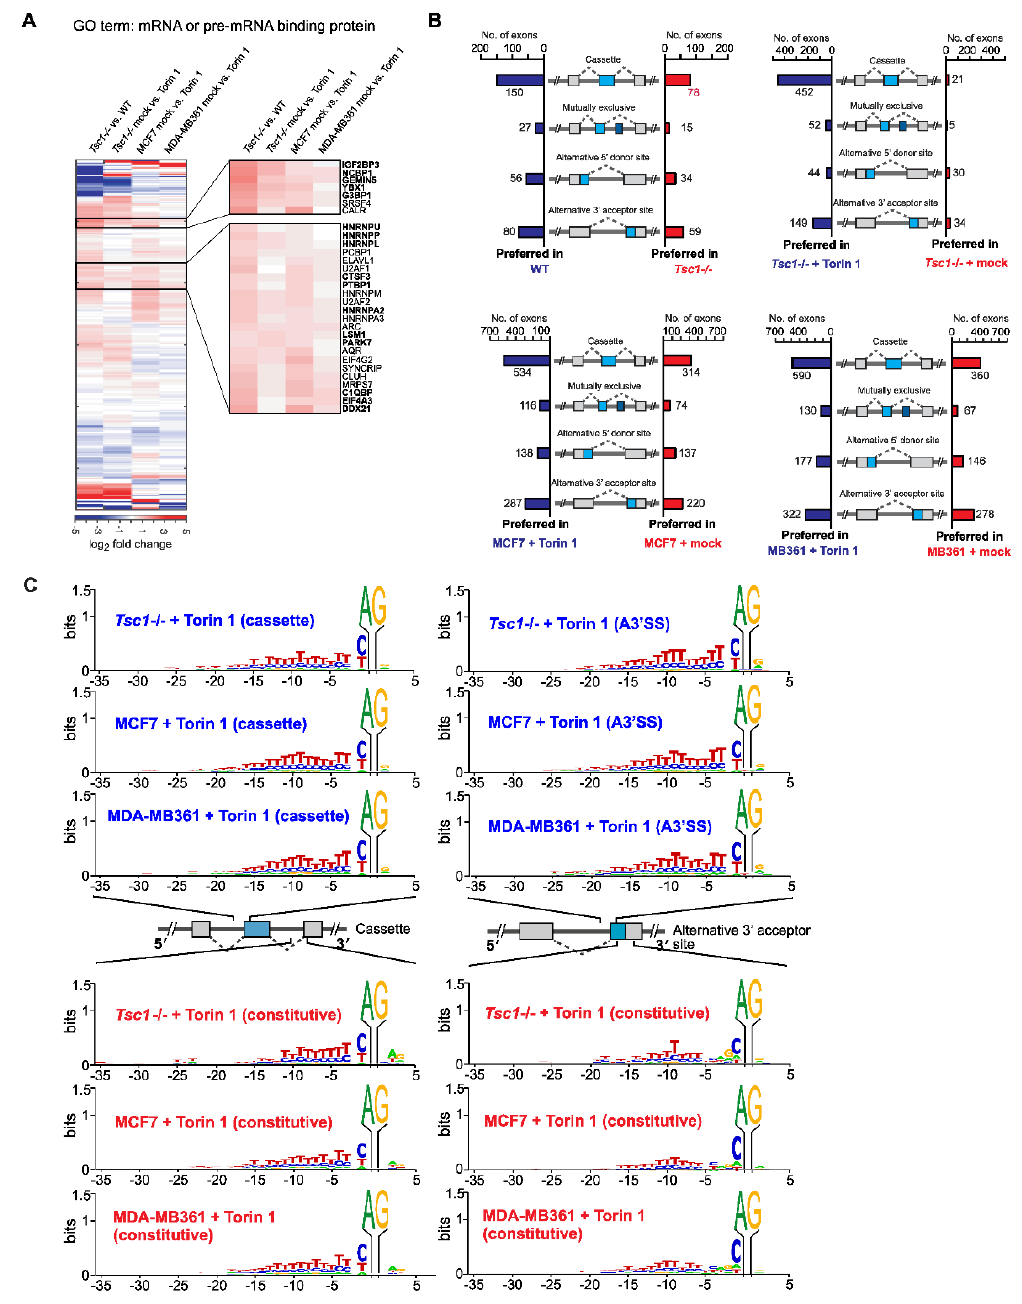
Figure 1. The mTOR-activated transcriptome features widespread exon skipping. ( A ) Hierarchical clustering of select RNA-binding proteins (RBPs) using differential gene expression analysis in low and high mTOR cellular environments. Comparisons were made in the combination of cells as indicated. The x-axis indicates the 285 different RBPs analyzed. The y-axis shows the combination of comparisons. The expression level is color-coded as shown in the scale bar and represents the log2 fold changes of gene expression. ( B ) Analyses of four different types of alternative splicing events in WT vs. Tsc1-/- MEFs; Tsc1-/- MEFs mock vs. Torin 1 treatment; breast cancer cell line MCF7 mock vs. Torin 1 treatment; MB361 mock vs. Torin 1 treatment. Cases of alternative exon inclusion are compared and illustrated in the combination as indicated in the figure. ( C ) The frequency of sequence preference of the 3′ -splice site at the AS exon compared to constitutively spliced exons for Tsc1-/- , MCF7, and MDA-MB361 mock- and Torin 1-treated cells. The x-axis represents the nucleotide position relative to the 3′ AG dinucleotide and the y-axis represents the certainty of the nucleotide.